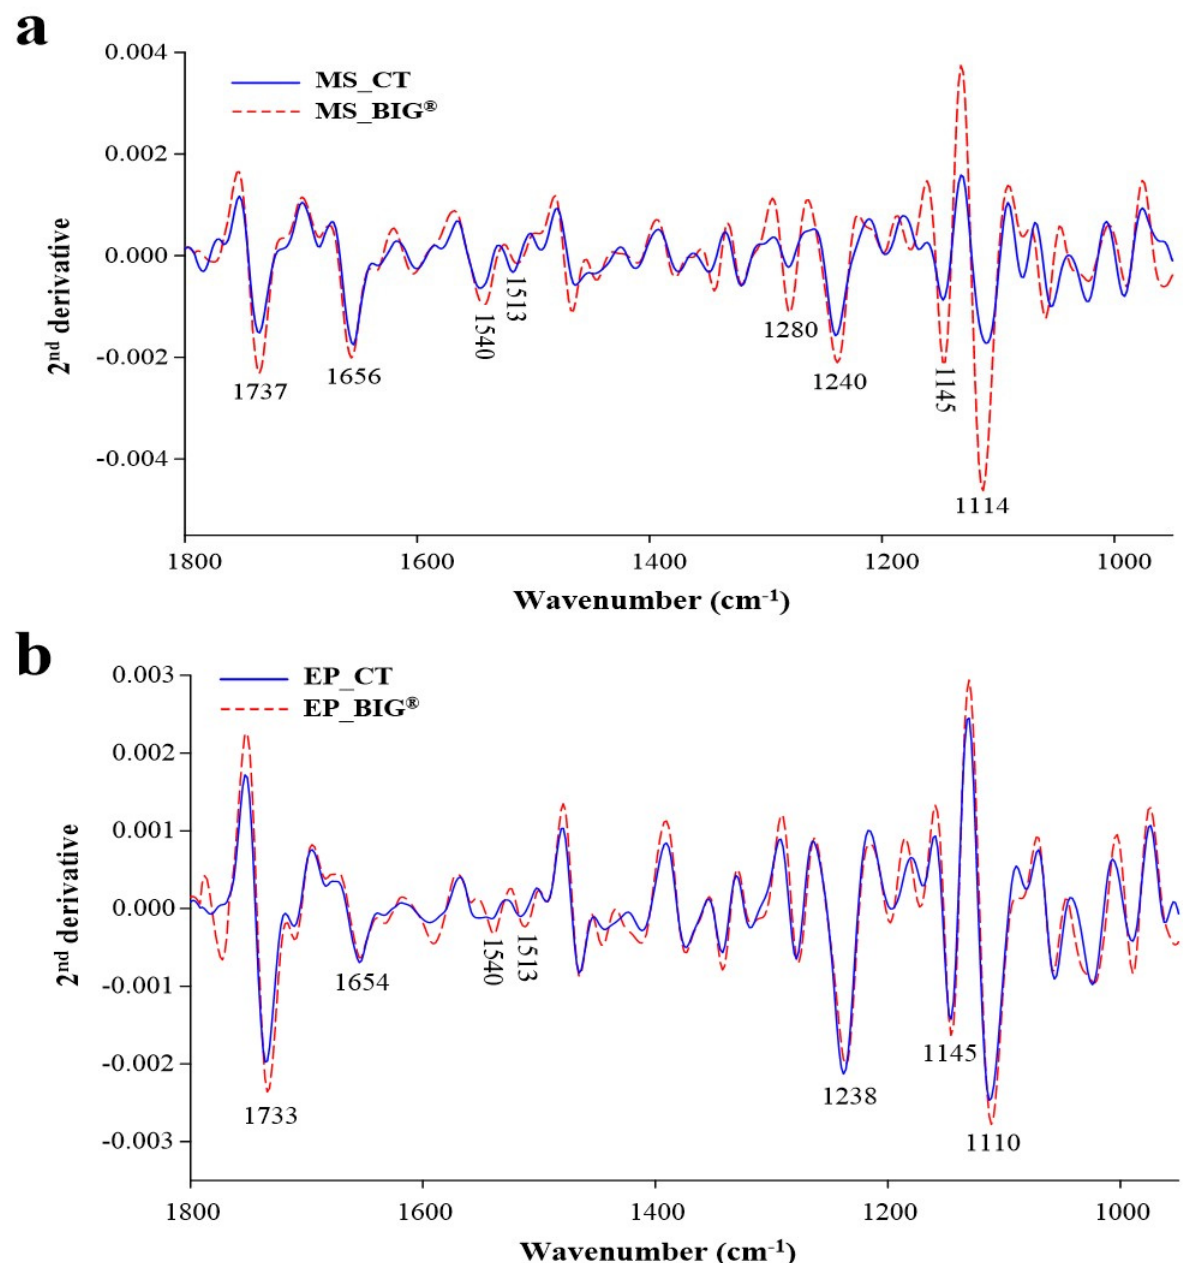
Figure 8. Representative second derivative average spectrum of the mesophyll and epidermis in rice leaves of cv. KDML 105 in an inoculation challenge with Xoo at 14 DAI under greenhouse conditions. ( a ) Mesophyll second derivative spectrum of rice after inoculation challenge with BIG ® compared with the control. ( b ) Epidermis second derivative spectrum of rice after inoculation challenge with BIG ® compared the control.